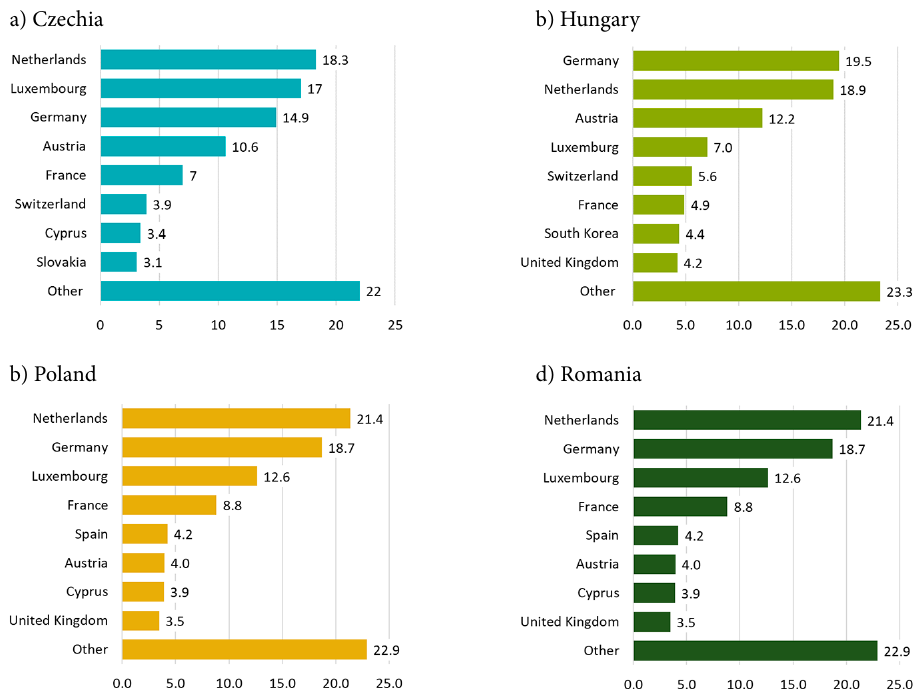
Figure A.3. FDI stock distribution by country at 31 December 2019 (source: Czech National Bank, Magyar Nemzeti Bank, Narodowy Bank Polski, National Bank of Romania, authors’ calculations)